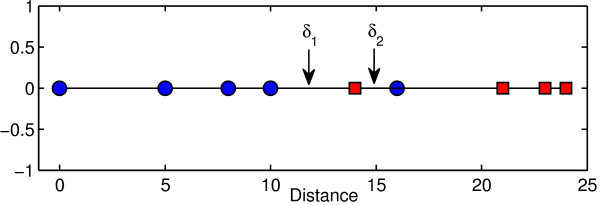
Candidate distance threshold. The distance threshold δ1 splits the dataset into two datasets so that it has 4 true positives, 0 false positive, 4 true negatives, and 1 false negative. The information gain of δ1 is 0.4090. The distance threshold δ2 divides the dataset into two datasets so that it has 4 true positives, 1 false positive, 3 true negatives, and 1 false negative. The information gain of δ2 is 0.1591. Hence, δ1 has better information gain than δ2.